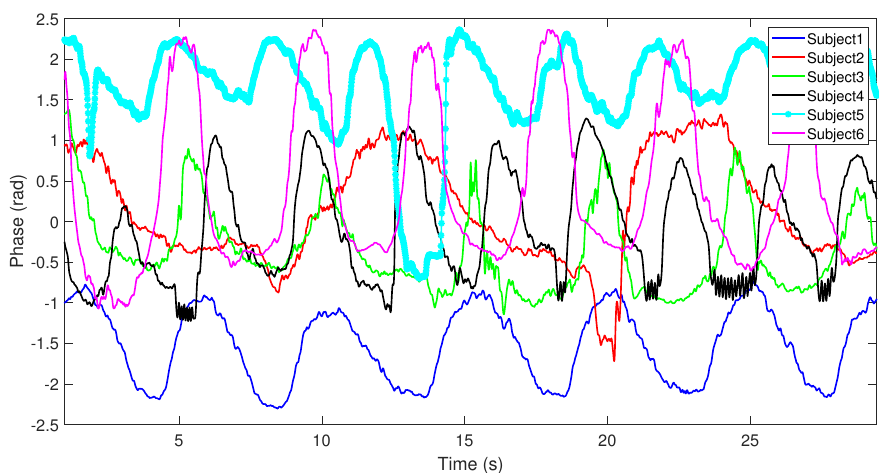
Figure 21. Respiratory signals of six subjects with a fixed